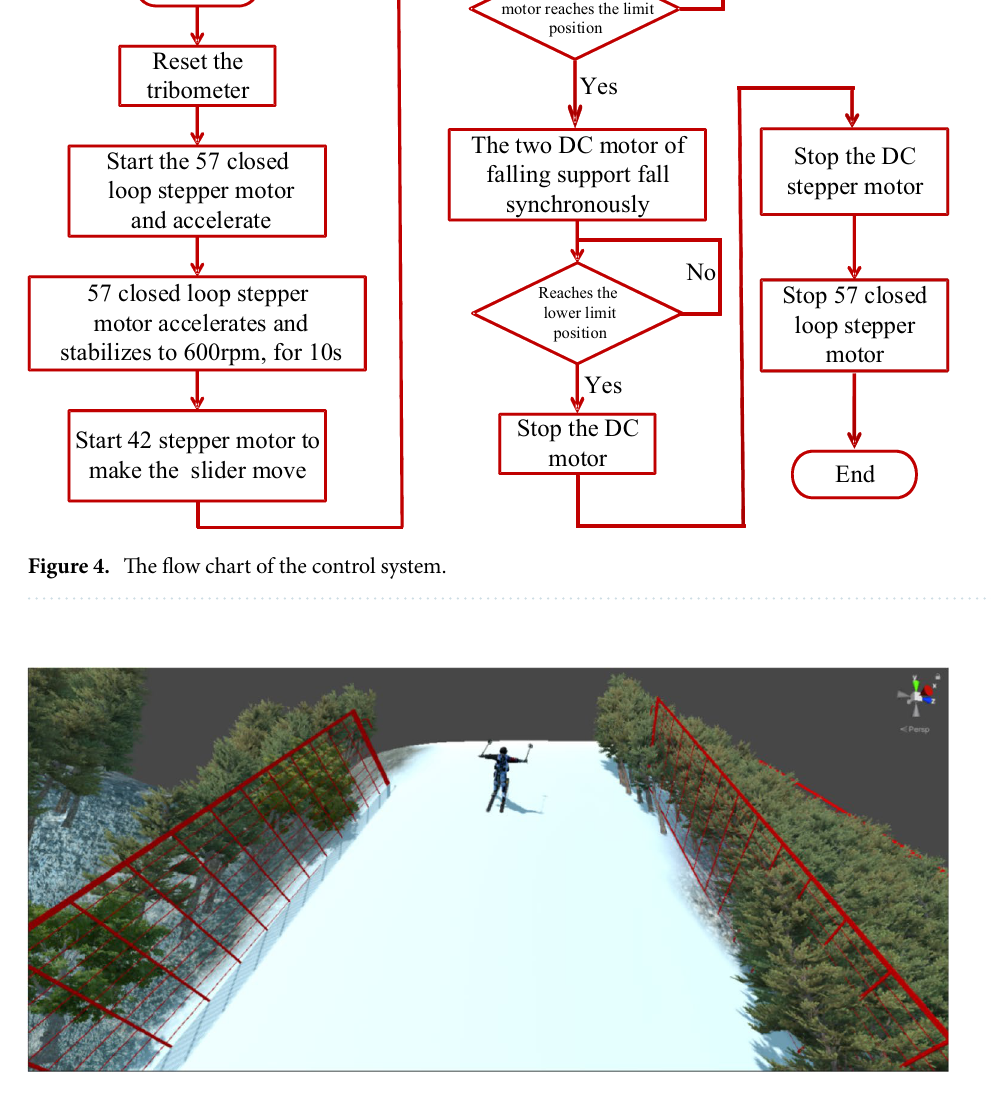
Figure 5. The virtual environment of the aerials event of freestyle skiing in Unity3D engine.